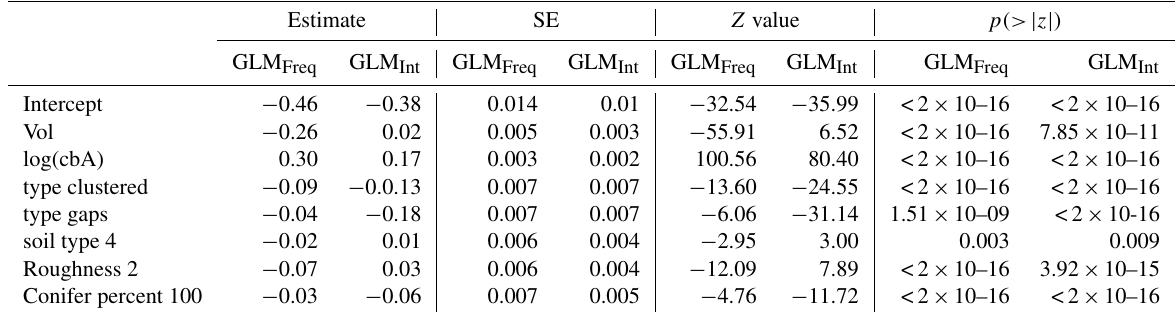
Table 3. Estimated regression coefficients, standard errors, Z values (i.e. ratio of estimate and standard error) and p values of the parametric explanatory variables and the intercept of the general linear model (GLM) for the reduction in rockfall occurrence frequency by forests (GLM Freq ) and the GLM for the reduction in rockfall intensity (GLM Int ) by forests. The models were fitted with a training set representing